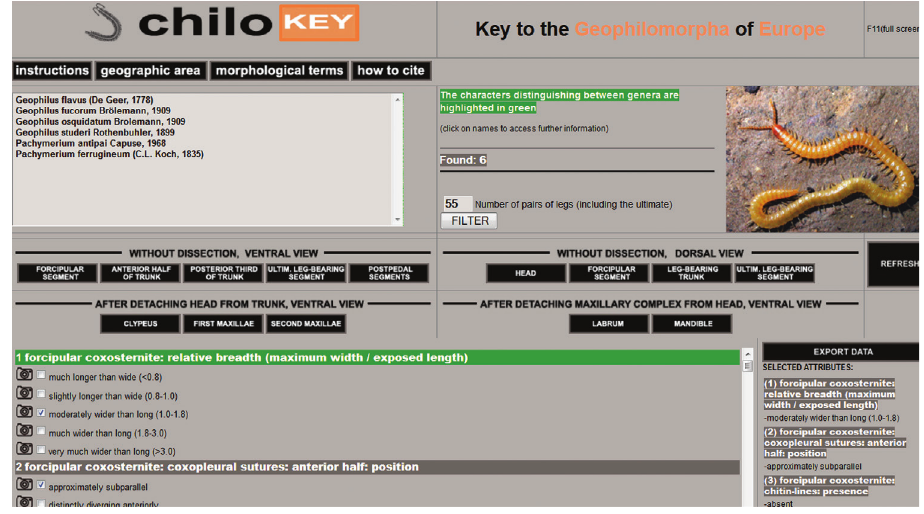
Figure 2. Screenshot of